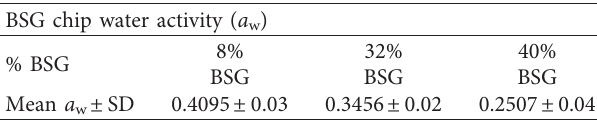
Table 3: Water activity ( a w ) of BSG chip product samples.